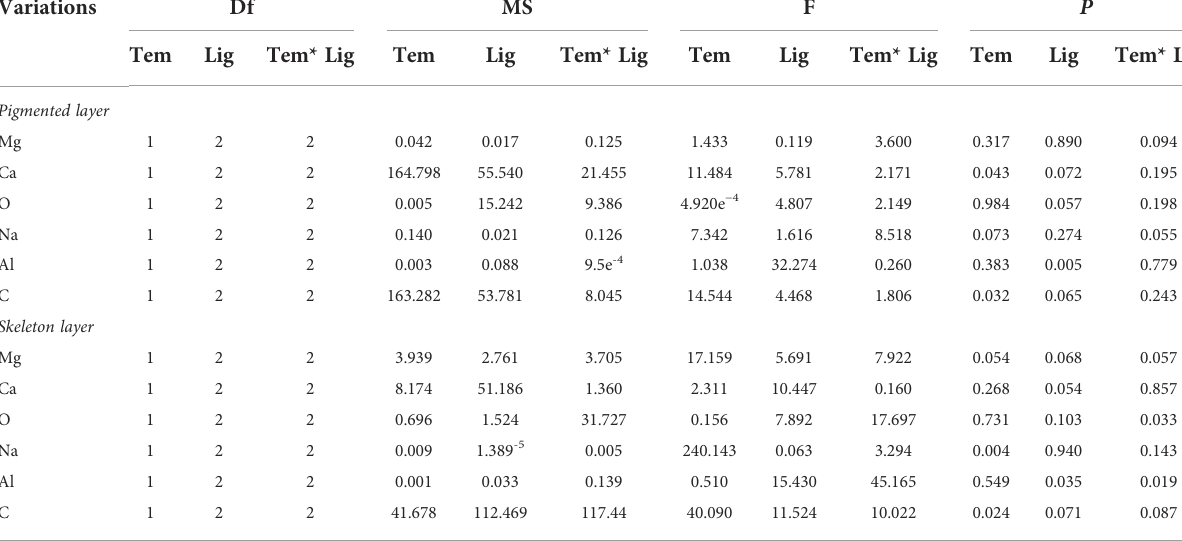
TABLE 2 Statistical analysis of main elemental compositions under different conditions. Variations